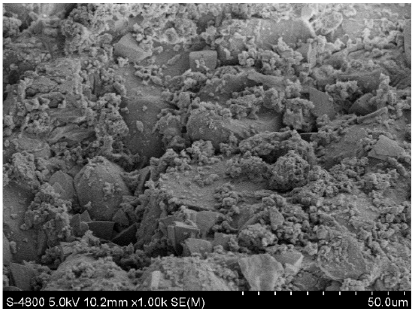
Figure 12. Garnet matrix after treatment.